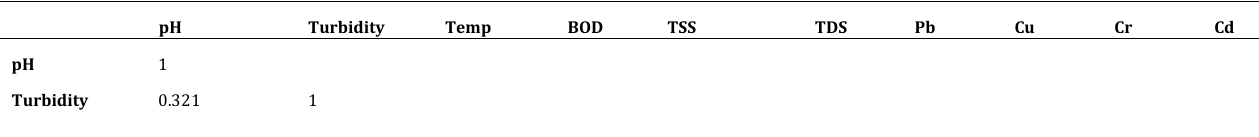
Table 5: Person correlation for spring-water at Bukit Bendera village, Kota